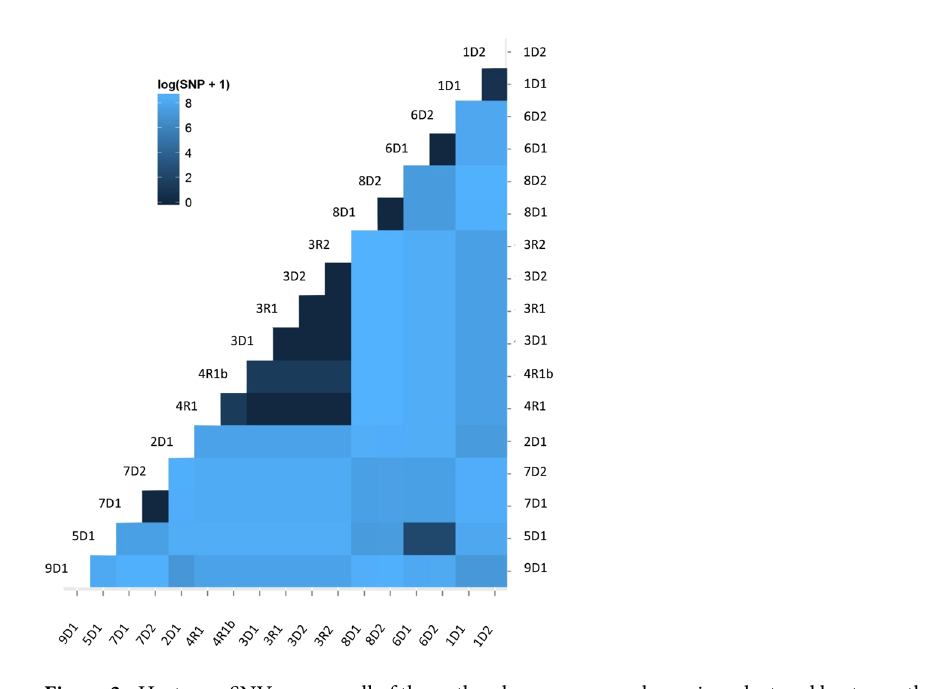
Figure 3. Heatmap. SNVs among all of the outbreak genomes are shown in a clustered heat map that is calculated by the log value ( + 1, in the case of an occurrence of zero) of the DNA sequence variations among the isolates. The shade degree of each grid represents the SNVs between two genomes. The deeper the color is, the more similar the